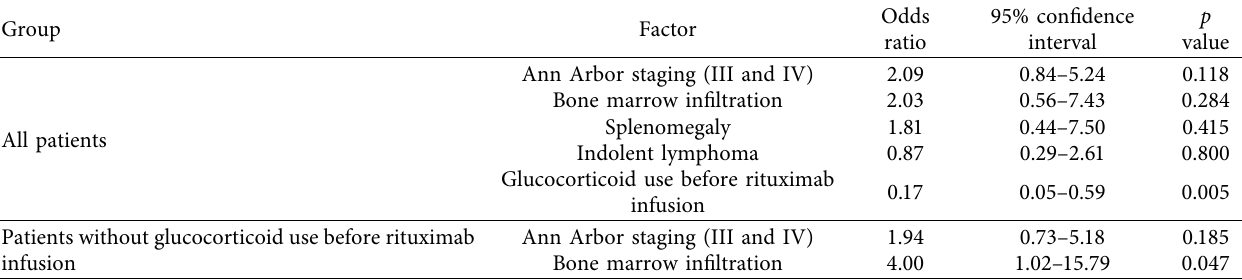
Table 2: Multivariate logistic regression